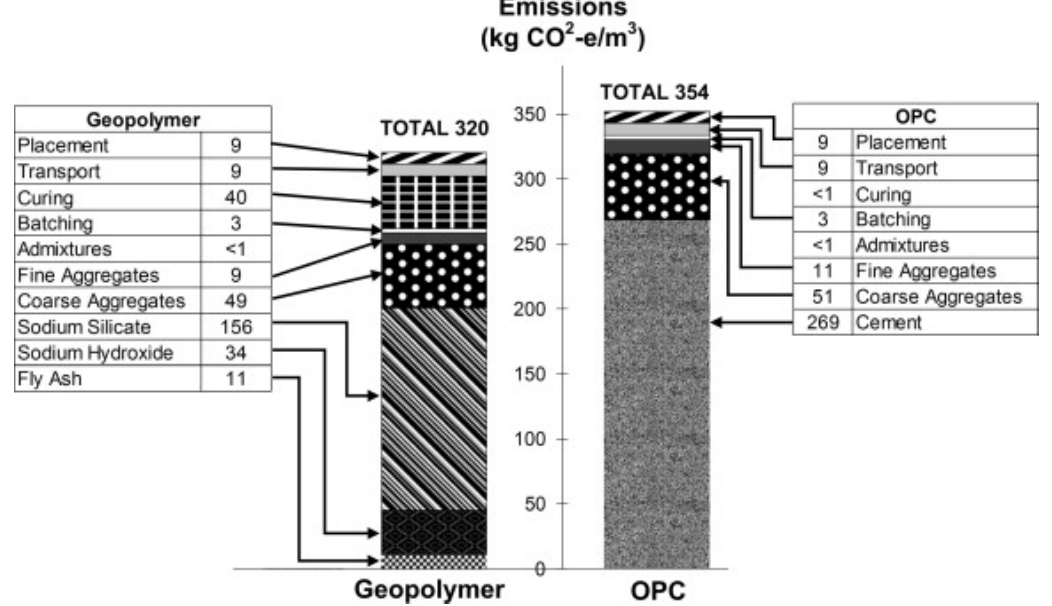
Figure 3: Summary of CO2-e for Grade 40 concrete mixtures with OPC and geopolymer binders [5]